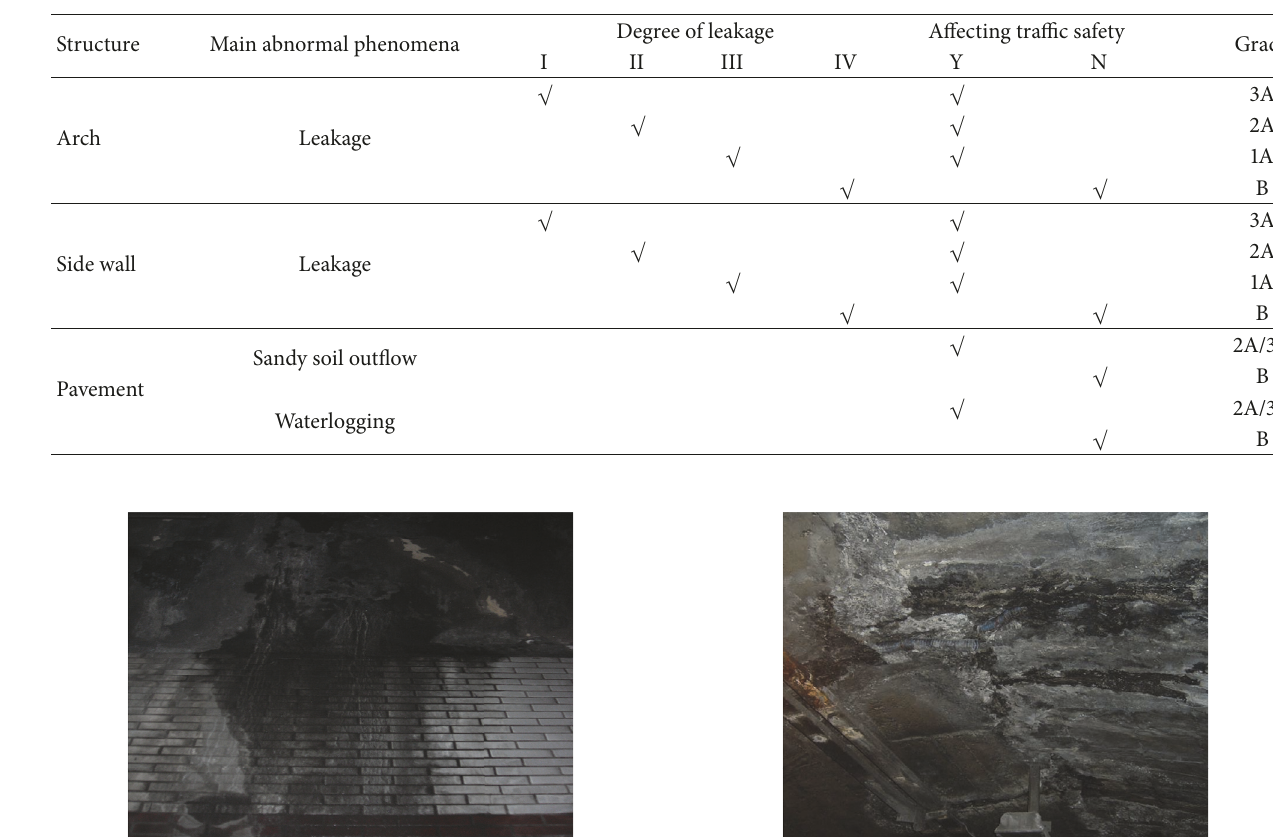
Table 3: Investigation on the tunnel seepage.